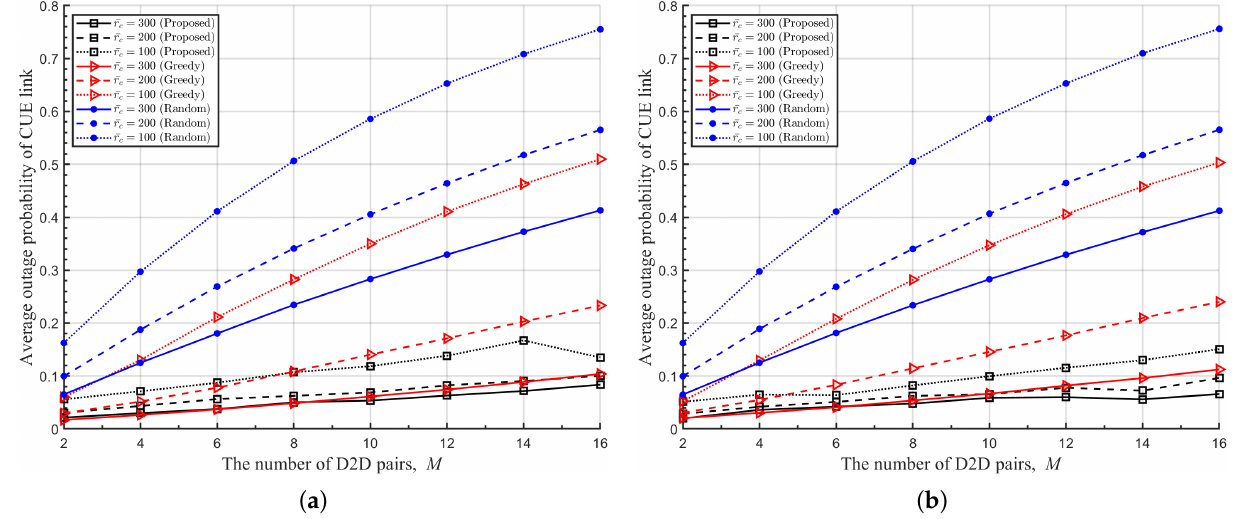
Figure 10. Average outage probability of cellular links with respect to M for various ¯ r c . ( a ) R c = 6 [bits/s/Hz], ( b ) R c = 8